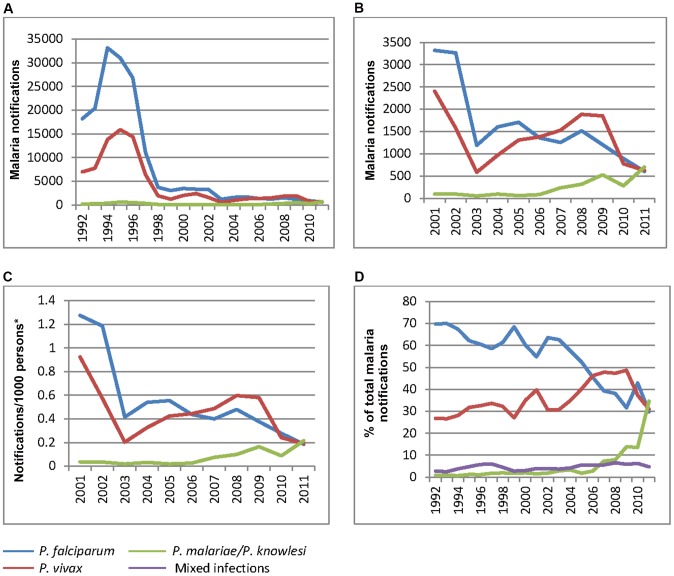
Malaria trends in Sabah, 1992–2011.
A. Annual malaria notifications by species 1992–2011; B. Annual malaria notifications by species 2001–2011; C. Malaria incidence by species 2001–2011; D. Annual notifications of species as a percentage of total malaria notifications, 1992–2011. *Population projections based on adjusted 2000 and 2010 population [24].